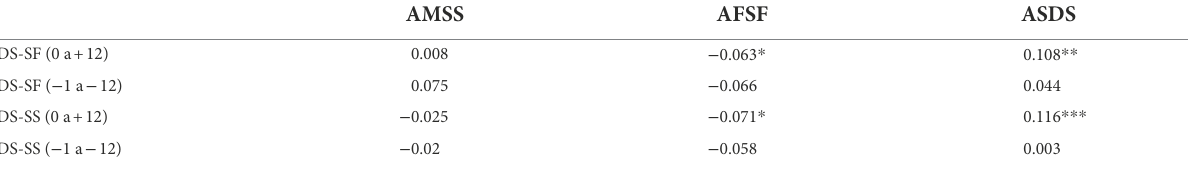
TABLE 5 Correlations between the Index of Double Standard for Sexual Freedom and Index of Double Standard for Sexual Shyness with index of perceived normativity of sexual gender norms. AMSS